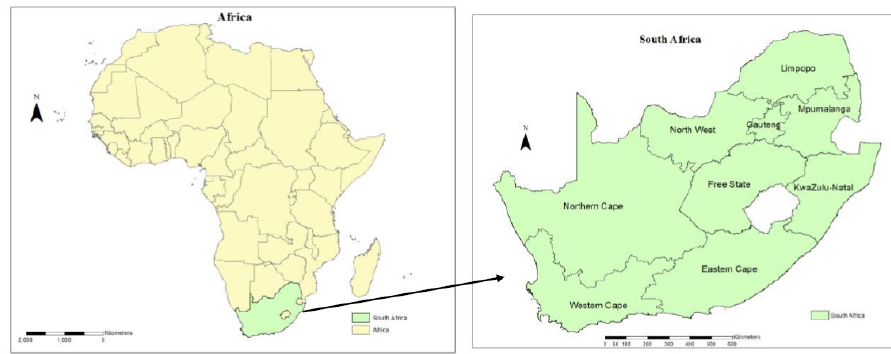
Figure 1. Location of South Africa.